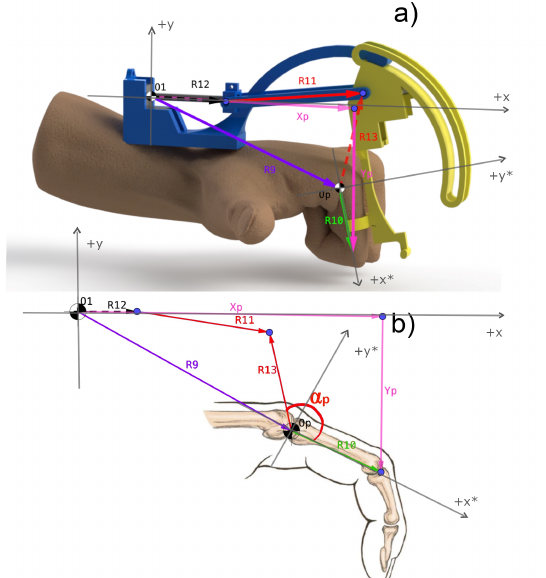
Figure 2. Figure illustrating the mechanism’s kinematic chains for the proximal phalanx movement. ( a ) Shows the vectors superimposed on the mechanism’s 3D model. ( b ) Shows the vectors on the finger so the virtual center of rotation O p can be appreciated. Similarly to the first mechanism, as it can be seen in this figure, there are several vector paths of interest (represented in different colors). Combinations between different vector paths produce kinematic chains that will be used to generate vector loop equations. The * mark indicates a local plane of